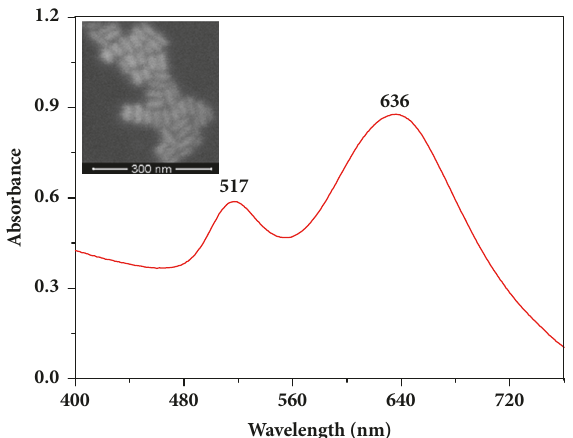
Figure 1: Ultraviolet-visible absorption spectrum of the prepared GNRs colloid; the inset is SEM image of